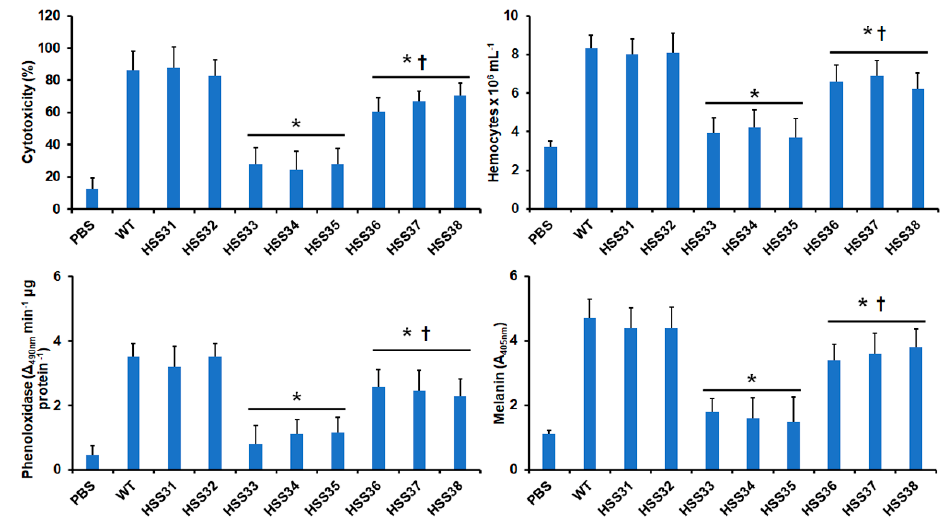
Figure 8. Cytotoxicity and immunological parameters of Galleria mellonella larvae infected with different strains of S. schenckii . G. mellonella larvae were infected with the different fungal strains as described in the Materials and Methods section and incubated for 24 h at 37 °C before animal decapitation and hemolymph collection. The cell-free hemolymph was used to measure lactate dehydrogenase activity, an indicator of cytotoxicity. The 100% cytotoxicity was the enzyme activity measured in lysate hemocytes. The other three parameters were quantified in anticoagulated total hemolymph. PBS, animal group inoculated only with PBS. Data represent means ± SD from ten animals per group, assayed by duplicate. * p < 0.05 when compared to wild-type (WT) strain. † p < 0.05 when compared to strains HSS33, HSS34, or HSS35.